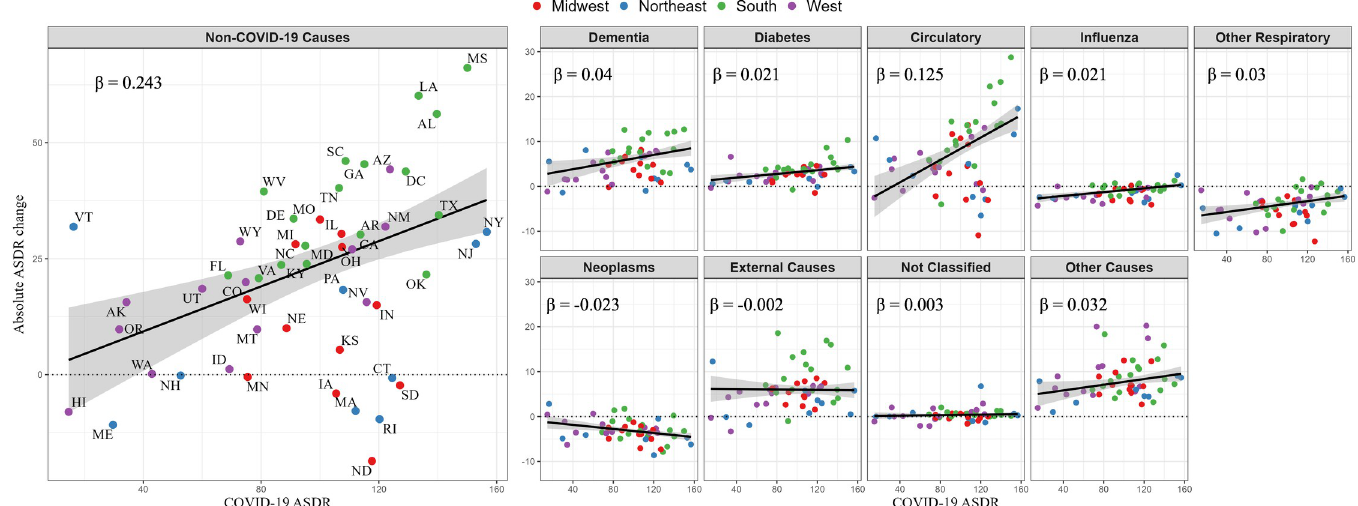
Fig 2. Association between state-level COVID-19 mortality and change in cause-specific mortality, ages 25+. Note: ASDR = age-standardized death rates. Change is measured as the age-standardized death rate in first full year of the pandemic (March 2020 to February 2021) relative to the same period a year prior (March 2019 to February 2020). Line reflects weighted linear regression where weights are the corresponding size of population in state i. Points above the dotted line indicates states with increases in cause-specific age ASDR, while below indicates decreases. β represents the change in ASDR for a particular cause of death associated with a 1 per 100,000 unit increase in COVID-19 ASDR. States are identified in the non-COVID-19 panel, with the associated abbreviations found in Table 1.